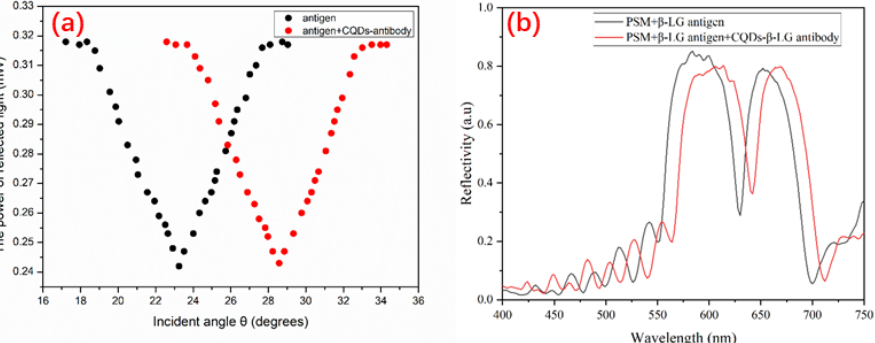
Figure 7. ( a ) Angle spectrum before the immune response and after the immune response. The black curve expresses the angle spectrum before the immune response, and the red curve represents the angle spectrum of the CQD-conjugated β -LG antibody; ( b ) Contrast of reflection spectra before and after connecting the β -LG antigen and CQDs- β -LG antibody in PSM.